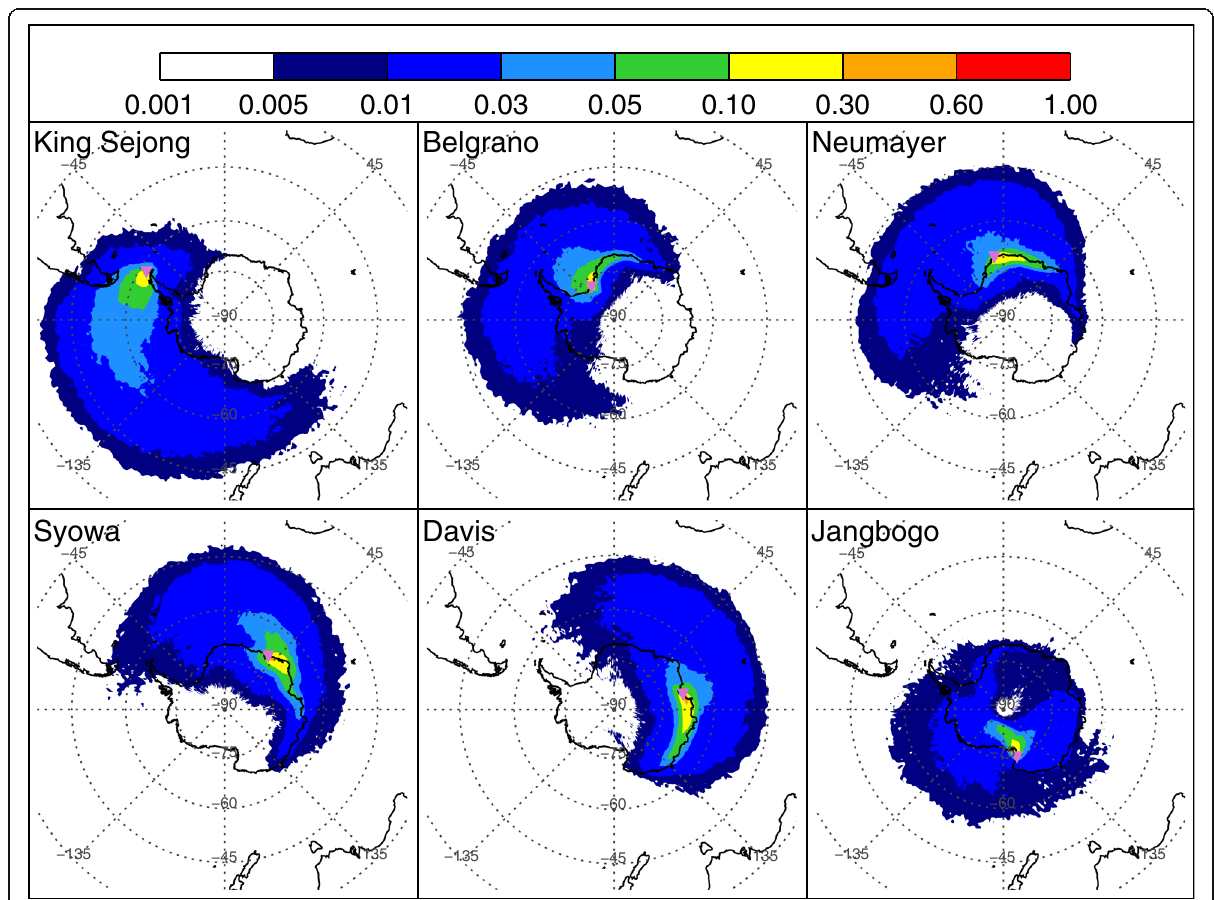
Fig. 5 Transport patterns using 10-day back trajectories arriving at the King Sejong, Belgrano, Neumayer, Syowa, Davis, and Jangbogo stations. Triangle marks indicate site locations. Color indicates the probability of back trajectories passing through each